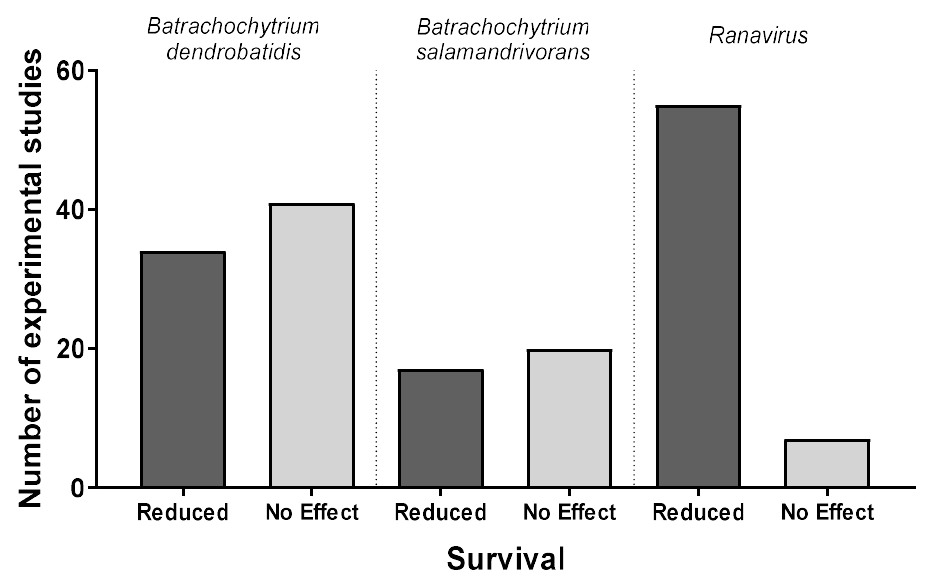
Figure 5. Effects on survival in experimental studies. These data are direct counts from Table 1.